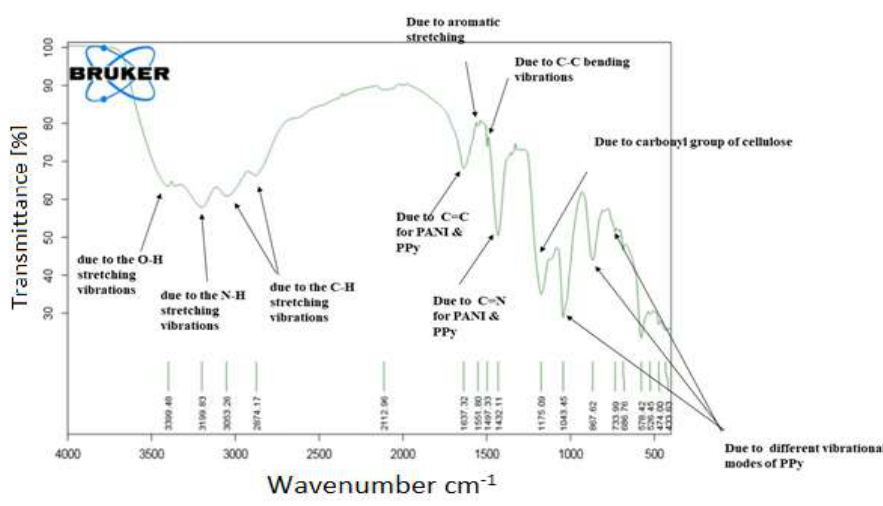
Figure 5. FT-IR spectrum of HEC.